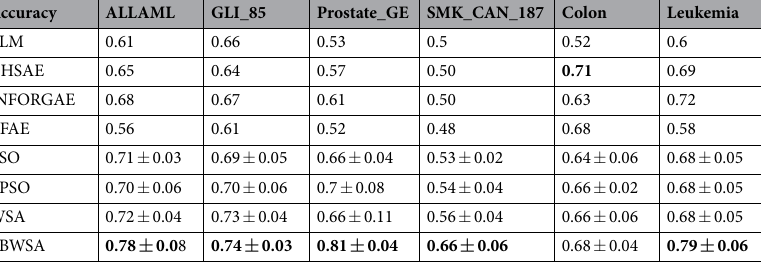
Table 1. Accuracy of all datasets with different methods (best results highlighted in bold).